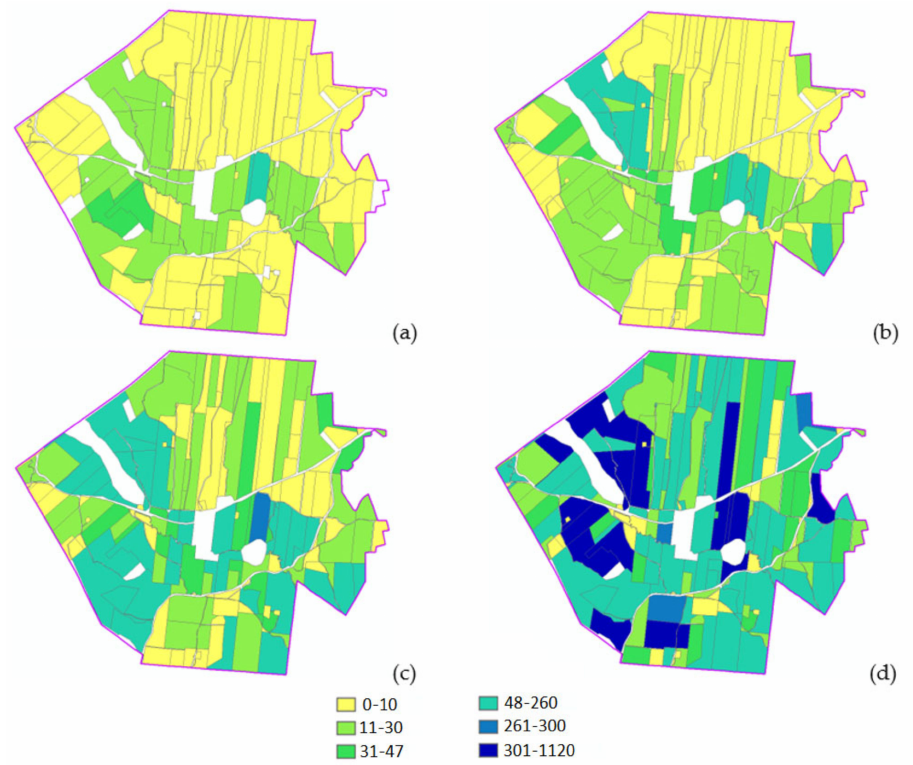
Figure 11. Visualisation of the maximum of the total LS factor values in the agriculture plots based on SRTM ( a ), DTED2 ( b ), LPIS ( c ) and ISOK ( d ) of the Bolcie research